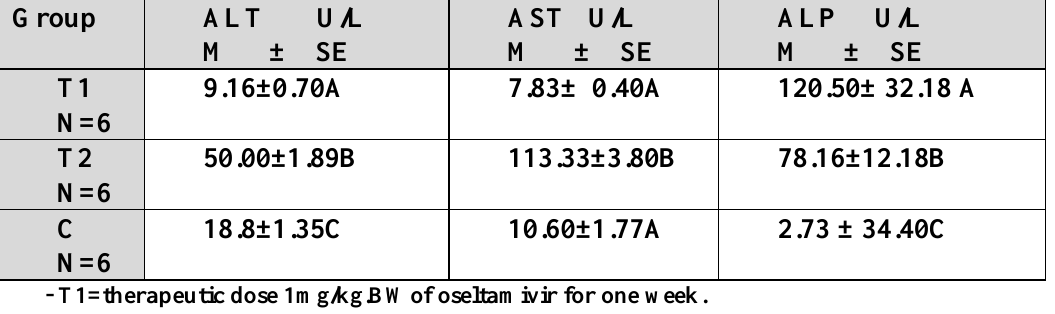
Table (2):- The serum activity of liver enzymes (ALT , AST ,ALP) U/L in rats dosed orally therapeutic dose 1mg/kg.BW of oseltamivir for different experimental